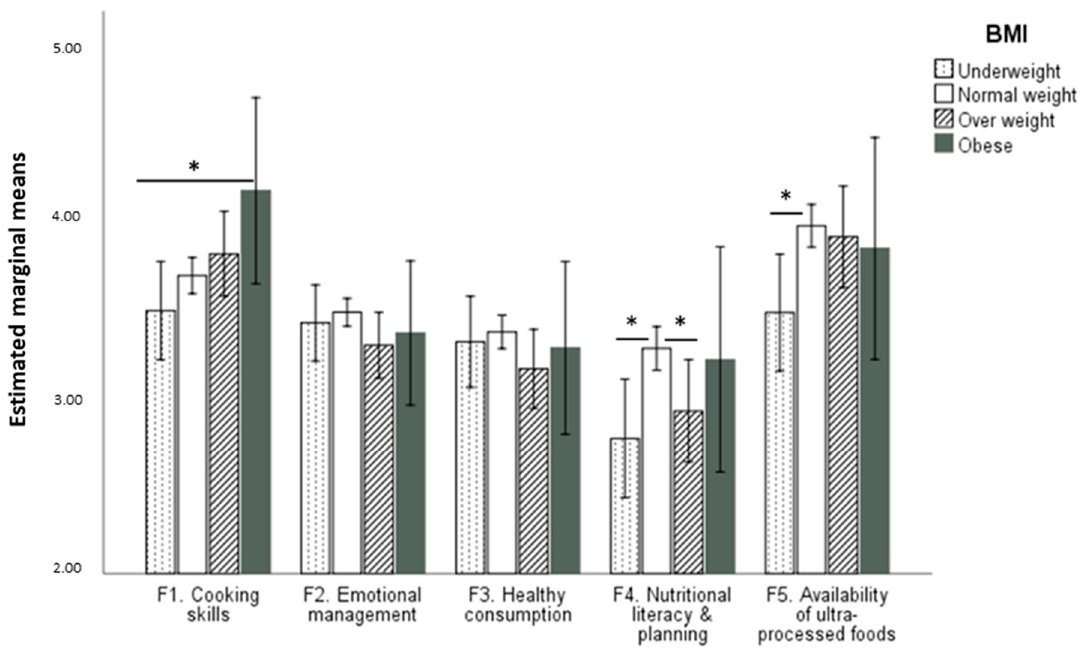
Figure 2. Estimated marginal means and post hoc significant differences for each BMI group in the SPFL factors (* p < 0.05).